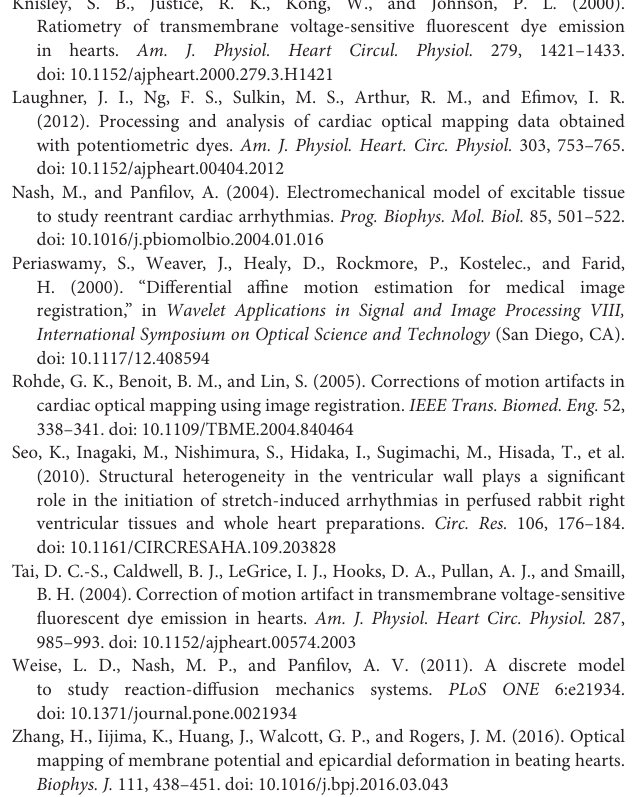
Figure 11. Without contrast-enhancement the tracking and motion-stabilized videos contain errors and heavy distortions respectively. Contrast-enhancement reduces mismatches between real simulated and tracked tissue configurations (red vectors)